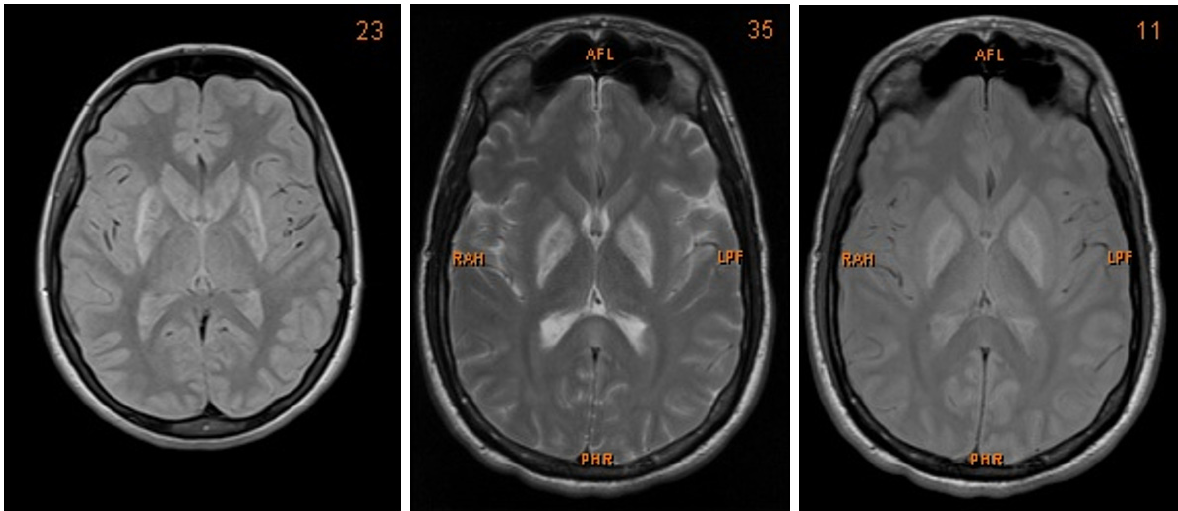
Figure 1. MRI images showing bilateral post-ischaemic lesions of the basal